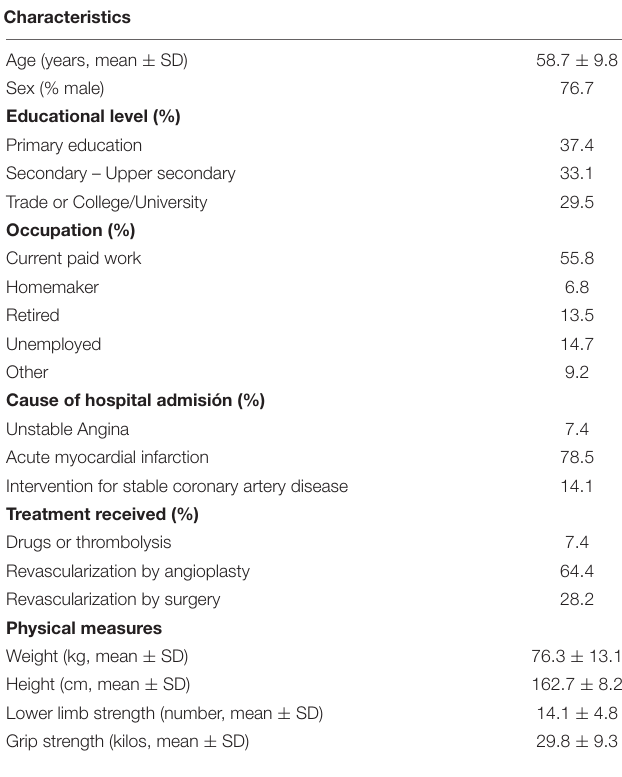
TABLE 1 | Baseline characteristics, clinical presentation, and